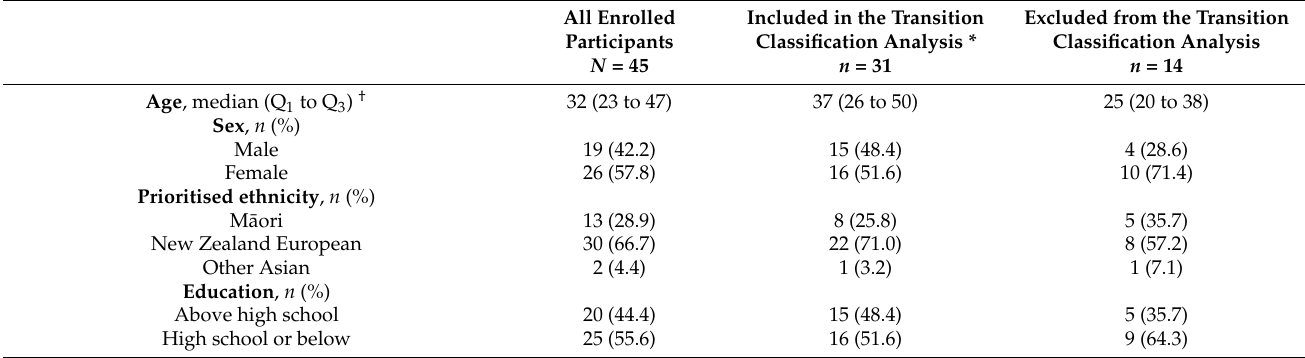
Table 1. Baseline characteristics of all enrolled Smoking-to-Vaping study participants ( N = 45), those included in the transition classification analysis ( n = 31) *, and those excluded from the transition analysis ( n = 14). All Enrolled